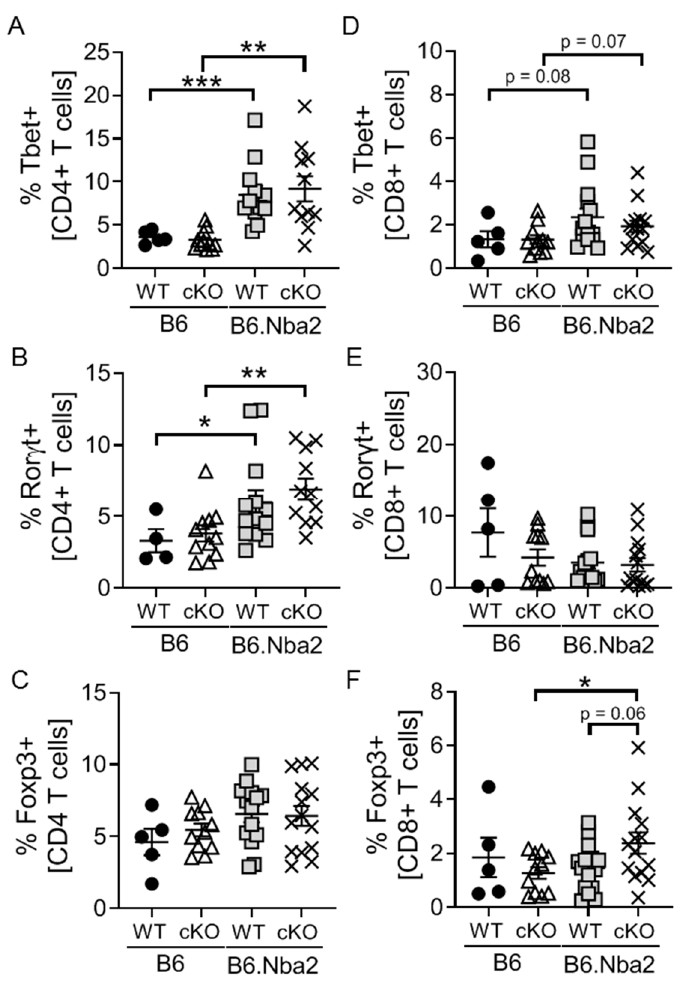
Figure 2. Accumulation of Th1, Th17 and Tc1 cells in B6.Nba2 mice is IFNAR independent. IFNAR- sufficient and -deficient female B6 and B6.Nba2 mice were analyzed for frequencies of CD4+ Th1, Th17 and Treg ( A – C ) and CD8+ Tc1, Tc17, Tcreg ( D – F ). Each symbol represent one mouse. n = 4–5 (B6), n = 11 (B6 cKO), n = 14 (B6.Nba2), n = 9 (B6.Nba2 cKO). * p < 0.05; ** p < 0.01; *** p < 0.001, Student’s unpaired t -test with Welch’s correction.